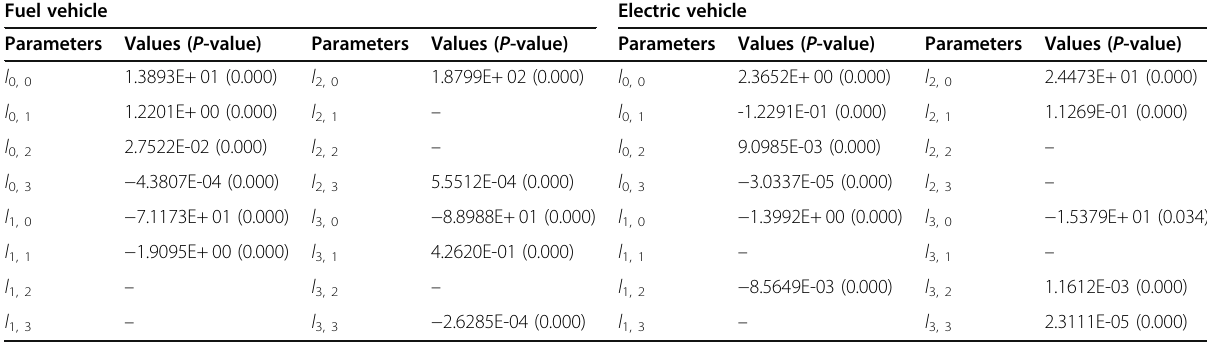
Table 6 Regression coefficient of the statistical model of CO 2 incremental emissions of fuel vehicles and electric vehicles Fuel vehicle